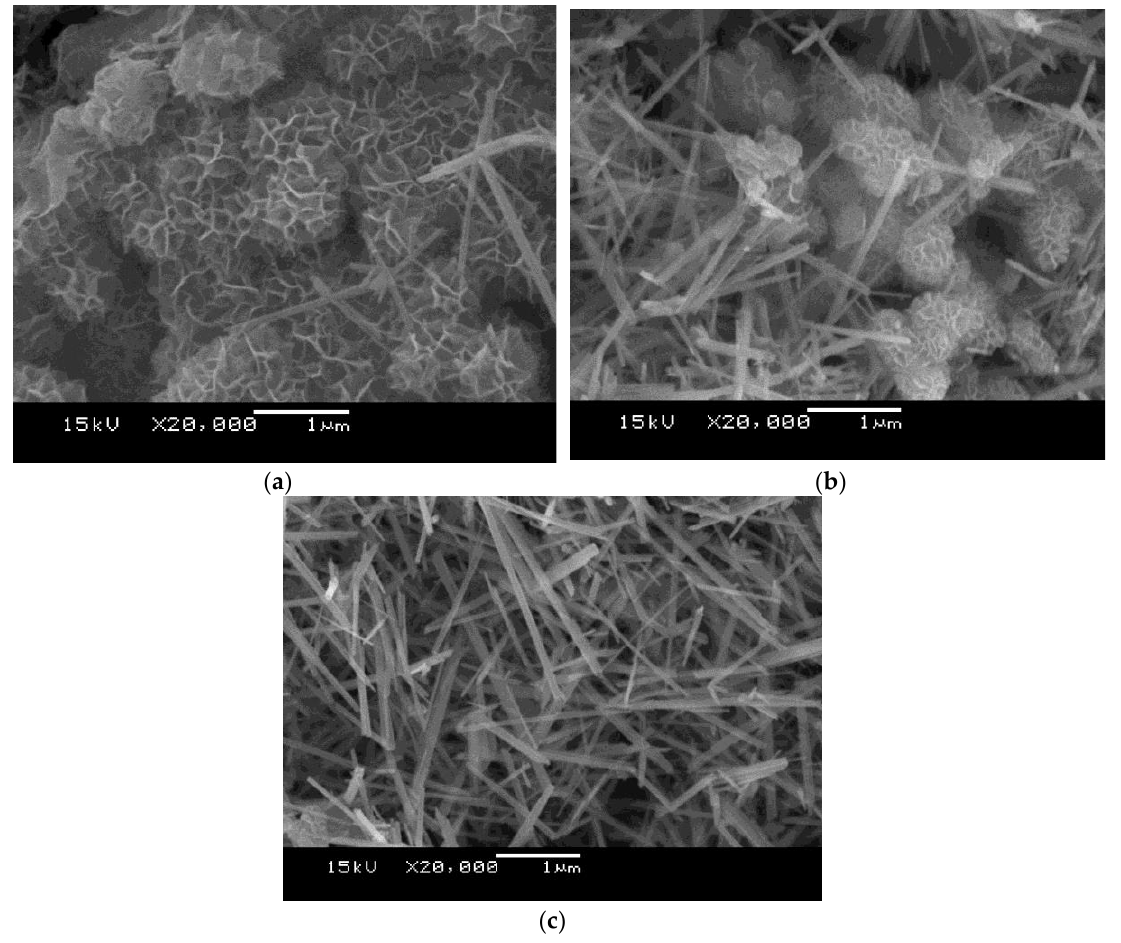
Figure 1. SEM images of synthesized MnO 2 with 2 ( a ), 4 ( b ), and 6 h ( c ) dwell time.